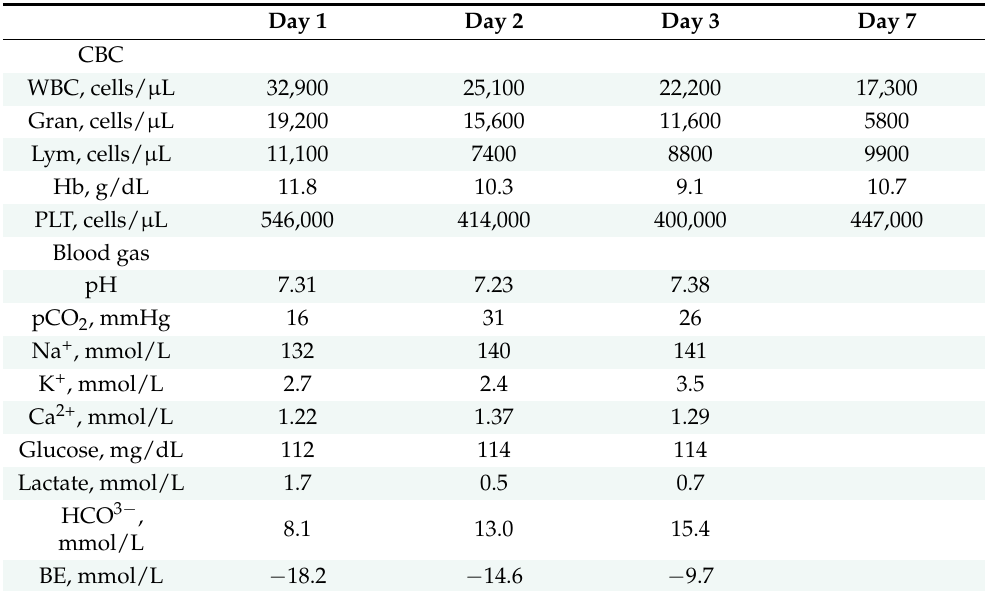
Table 1. Blood examinations at admission and during